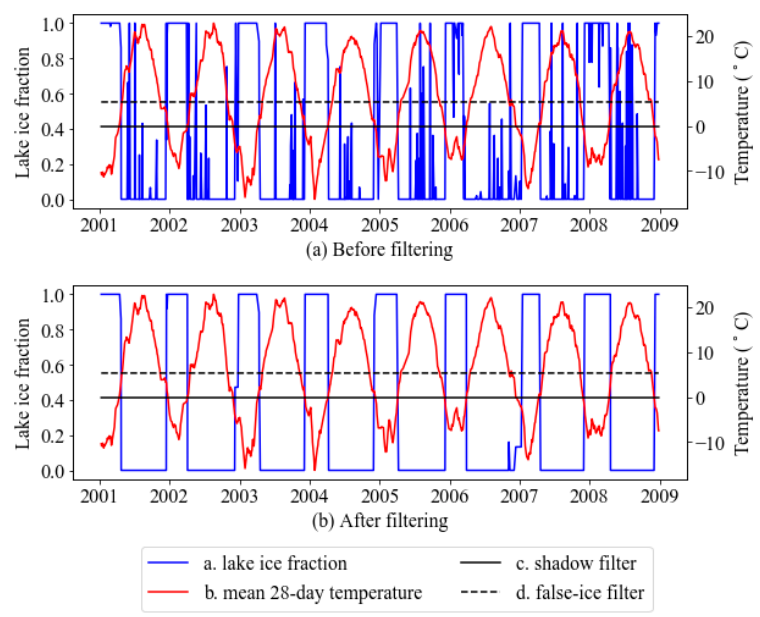
Figure4. TimeseriesoflakeicefractionandtemperatureoverSilverLake( a )beforeand( b Figure 4. Time series of lake ice fraction and temperature over Silver Lake ( a ) before and ( b ) after filtering.